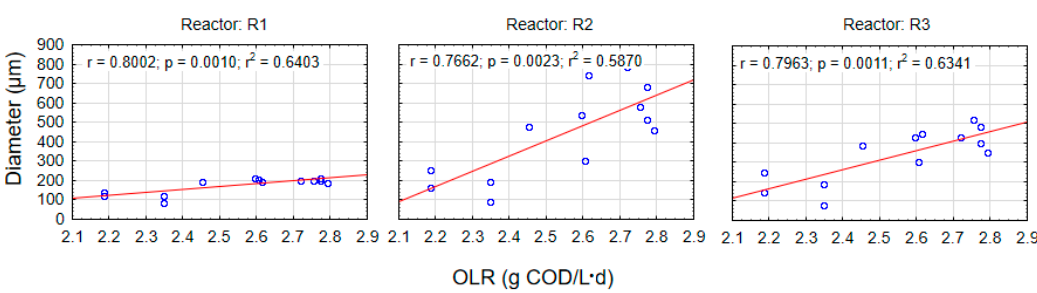
Figure 5. Scatter graph showing the relationship between granule diameter and OLR.